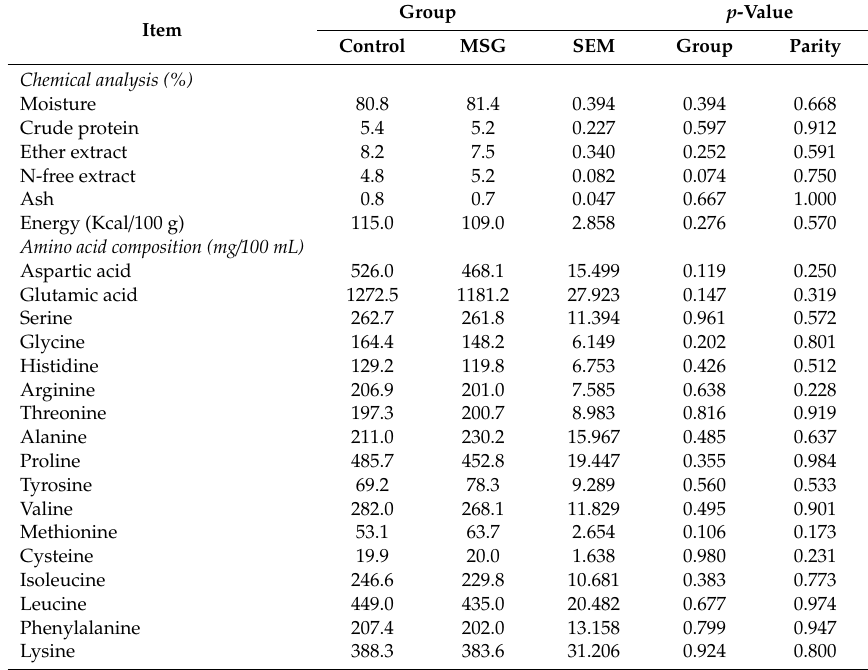
Table 2. E ff ect of monosodium glutamate (MSG) inclusion into maternal gestating and lactating diets on chemical and amino acid composition of sows’ milk 1